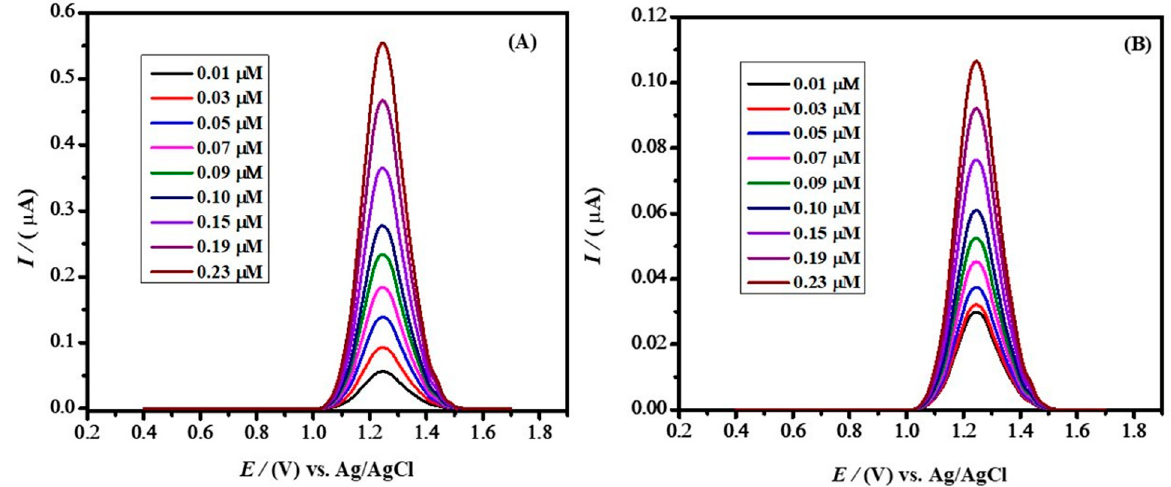
Figure 9. ( A ) DPV of IBP recorded with a supporting electrolyte of 0.9 M NaOH at different concen- trations in the absence of BSA ( B ) DPV of IBP recorded with a supporting electrolyte of 0.9 M NaOH at different concentrations in the presence of 1 mM BSA.